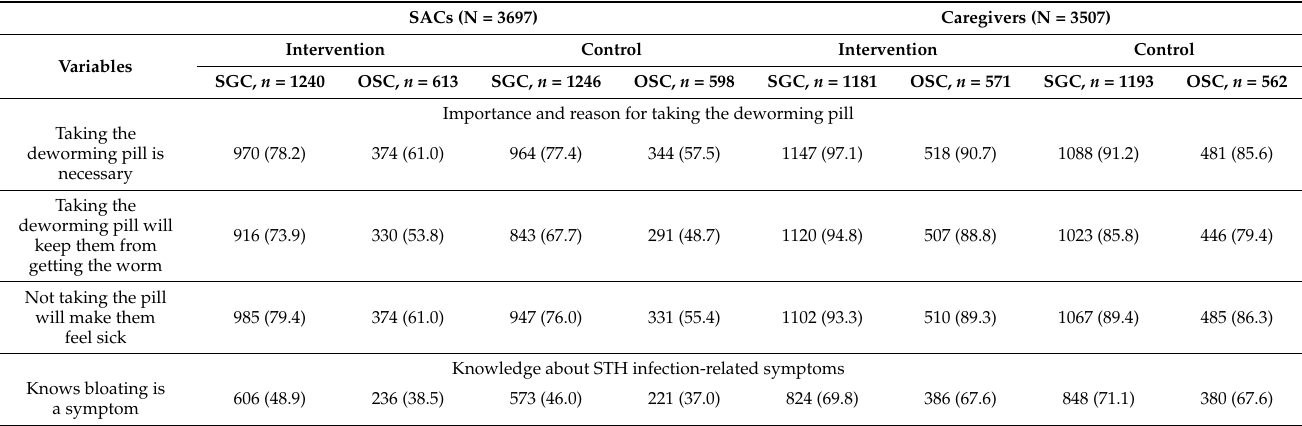
Table 3. Distribution of SACs and their caregiver’s knowledge across intervention and control groups.